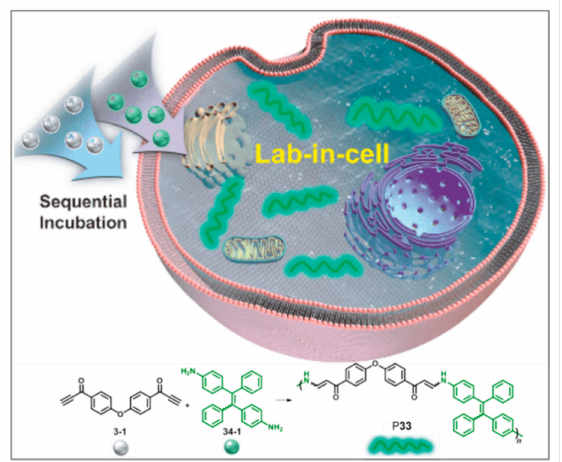
Figure 3. Illustration of the spontaneous amino-yne polymerization in cell. (Copyright 2019,